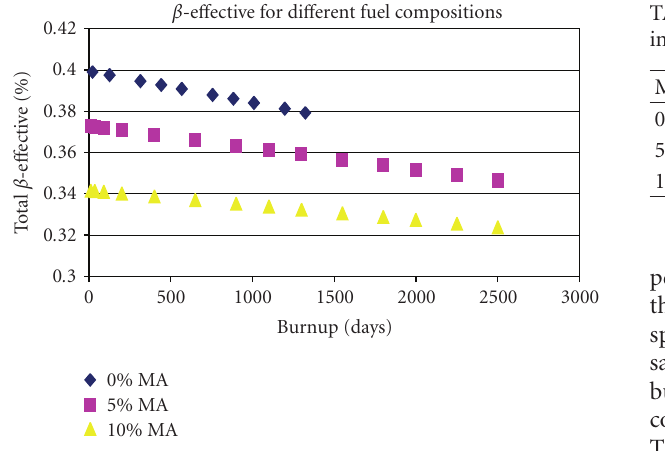
Figure 3: The e ff ective delayed neutron fraction decreases by 15% when the MA-fraction increases from 0% to 10%.